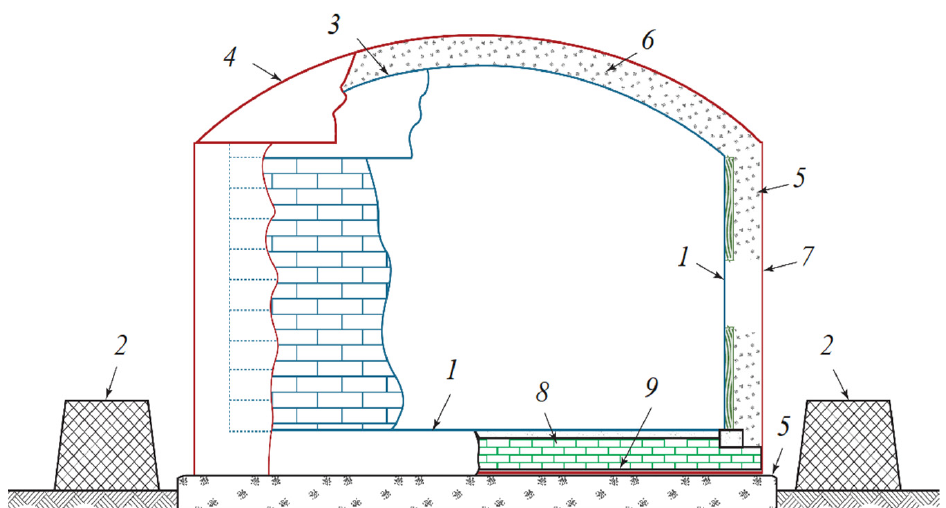
Figure 3. Schematic of a single-constraint double-wall cryogenic tank, where the primary container is of steel material; 1—Main liquid vessel, 2—Safety dyke, 3—Cryogenic temperature roof, 4—Purge gas container, 5—foundation, 6—Insulation layer, 7—Purging gas shell, 8—floor insulation, 9—Outer bottom purge gas containment [38].